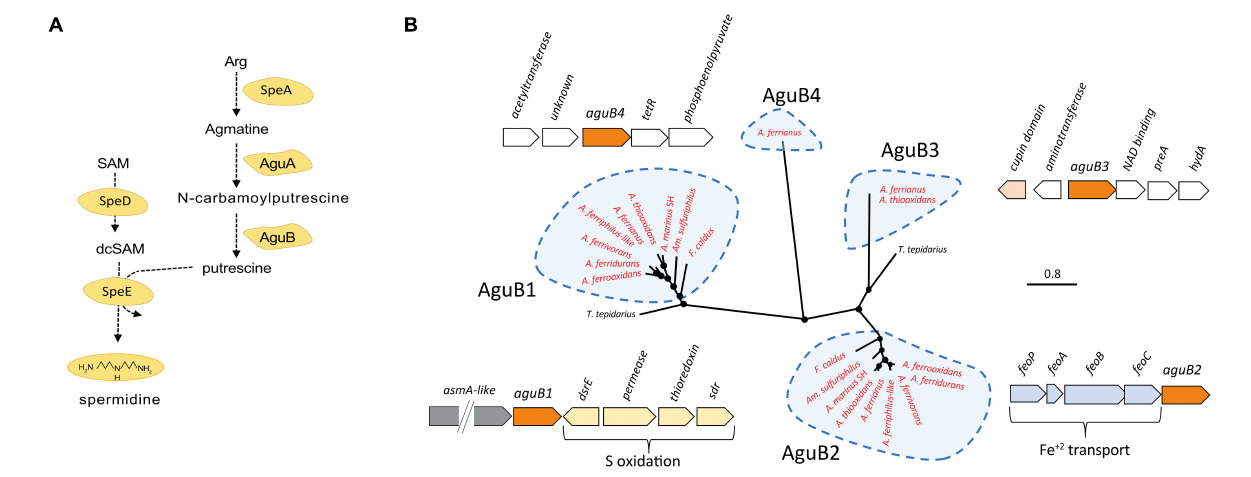
FIGURE 3 | (A) Putrescine and spermidine biosynthesis pathway. (B) Unrooted phylogenetic tree of Acidithiobacillia class agu B amino acid sequences and their best hits in the NCBI databases plus their genomic context in the Acidithiobacillaceae ( agu B in orange color). Sequences of agu B group in four clades denominated